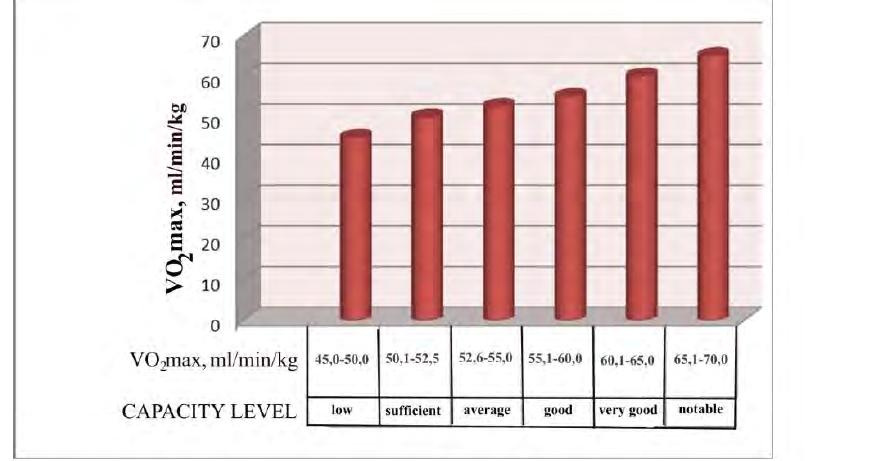
Fig.7. Workability levels of qualified handball players in “Beep